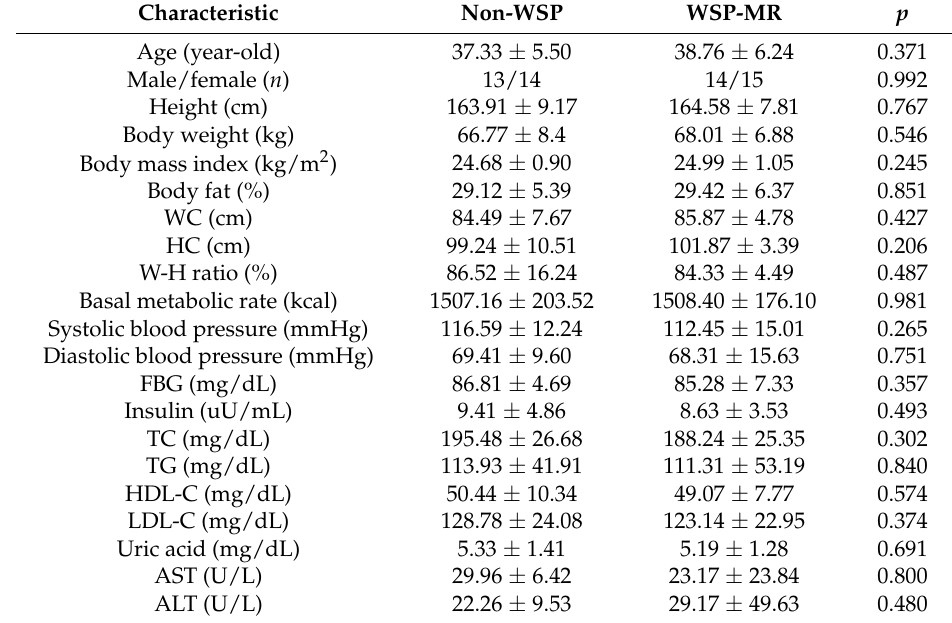
Table 2. Demographic and clinical characteristics of the participants.